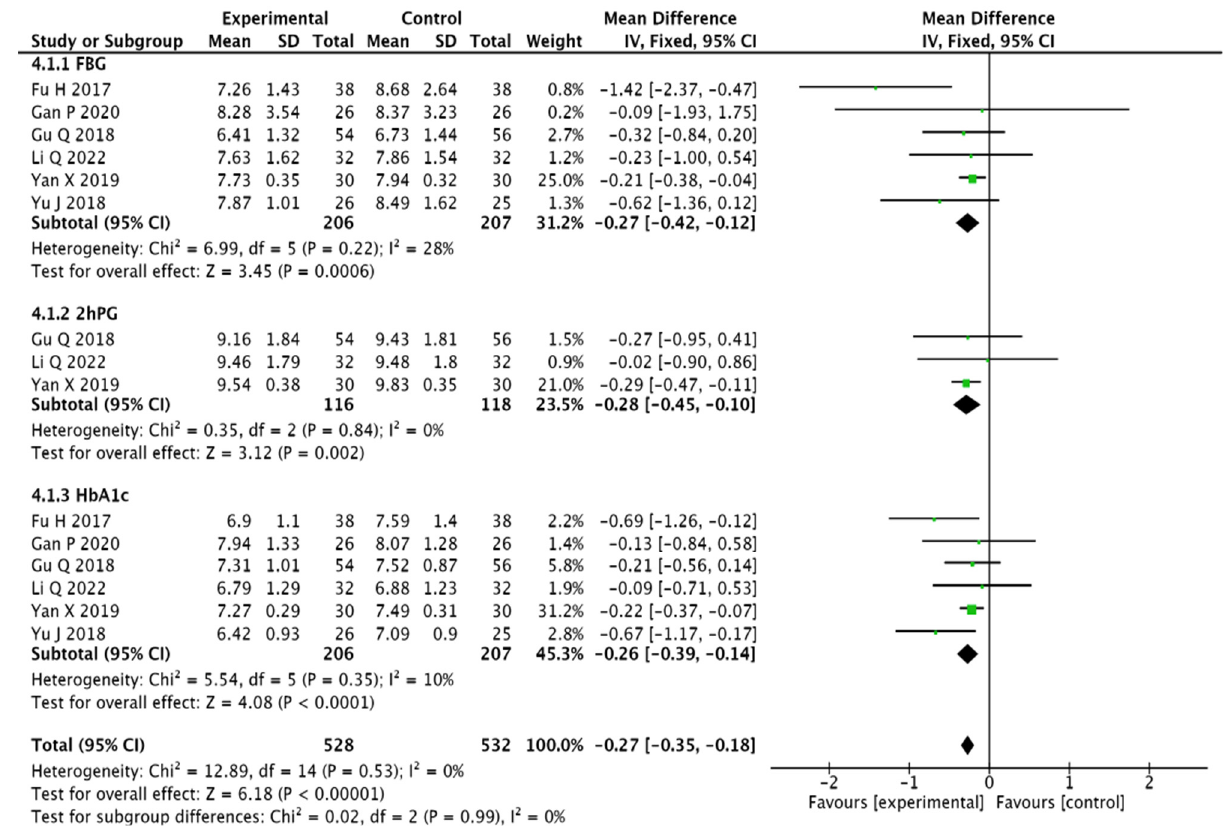
Figure 8. Meta-analysis forest plot of blood glucose [13,15–17,19,21].